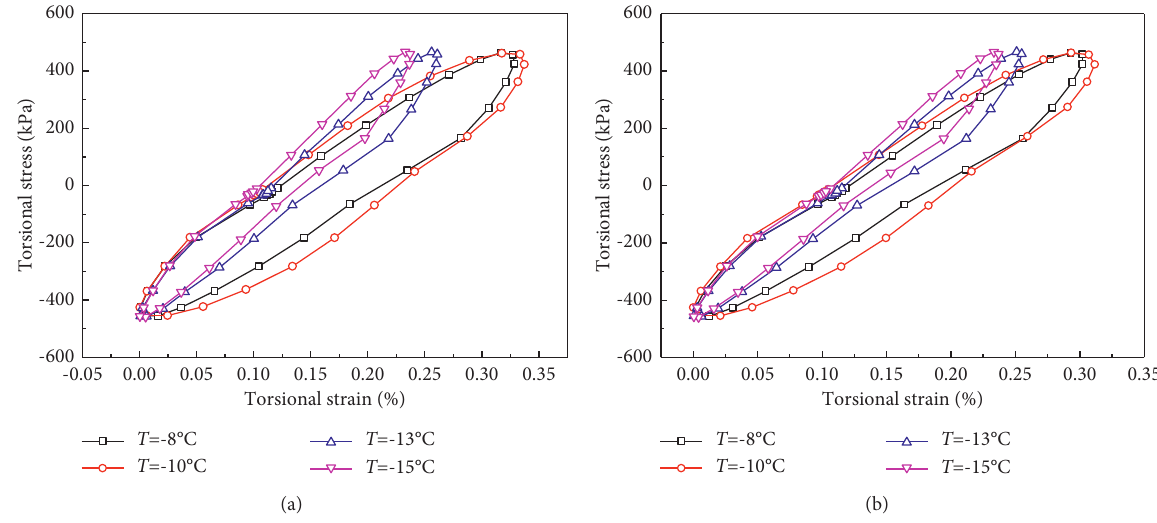
Figure 14: Representative torsional stress-strain responses for a given number of cycles under different temperatures. (a) N � 50. (b) N � 200.